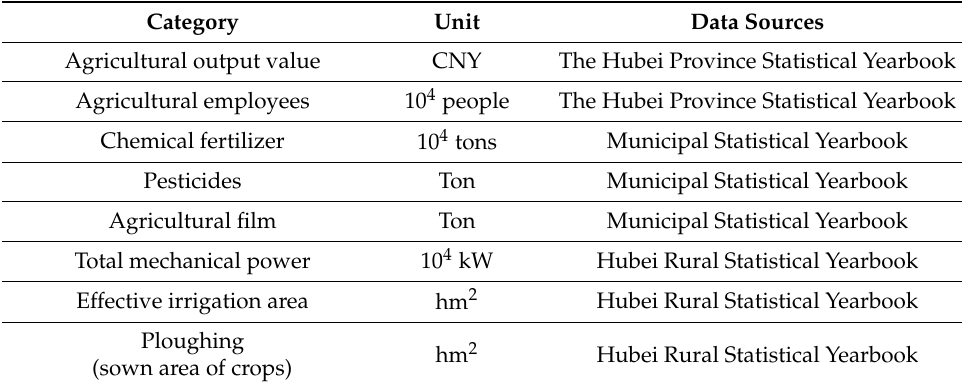
Table 3. Unit and source of each